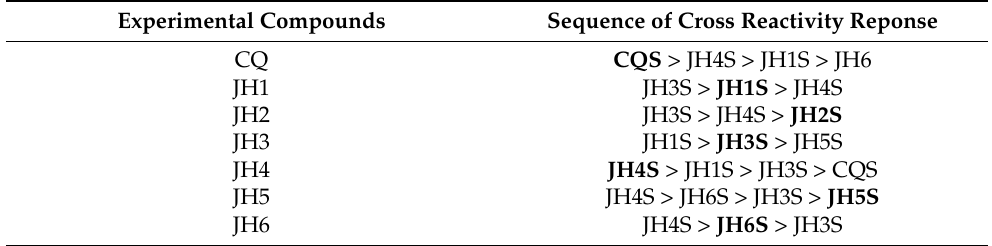
Table 3. Cross-reactivity of antibody with antigen from highest to lowest humoral response. Each antigen’s order of cross-reactivity is presented, and each hyperimmune sera is highlighted in bold.